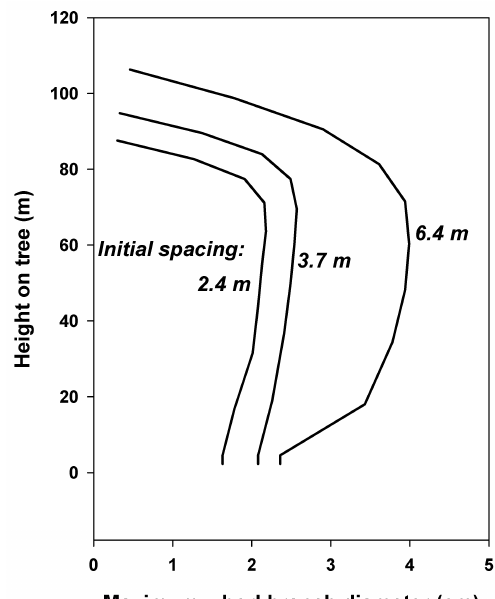
Figure 11. Results from ORGANON growth model simulations showing vertical pattern in maximum whorl branch diameter on the tree representing the 50th percentile of the dbh distribution under three different initial spacings (2.4, 3.7, and 6.4 m) grown out to a total age of 49